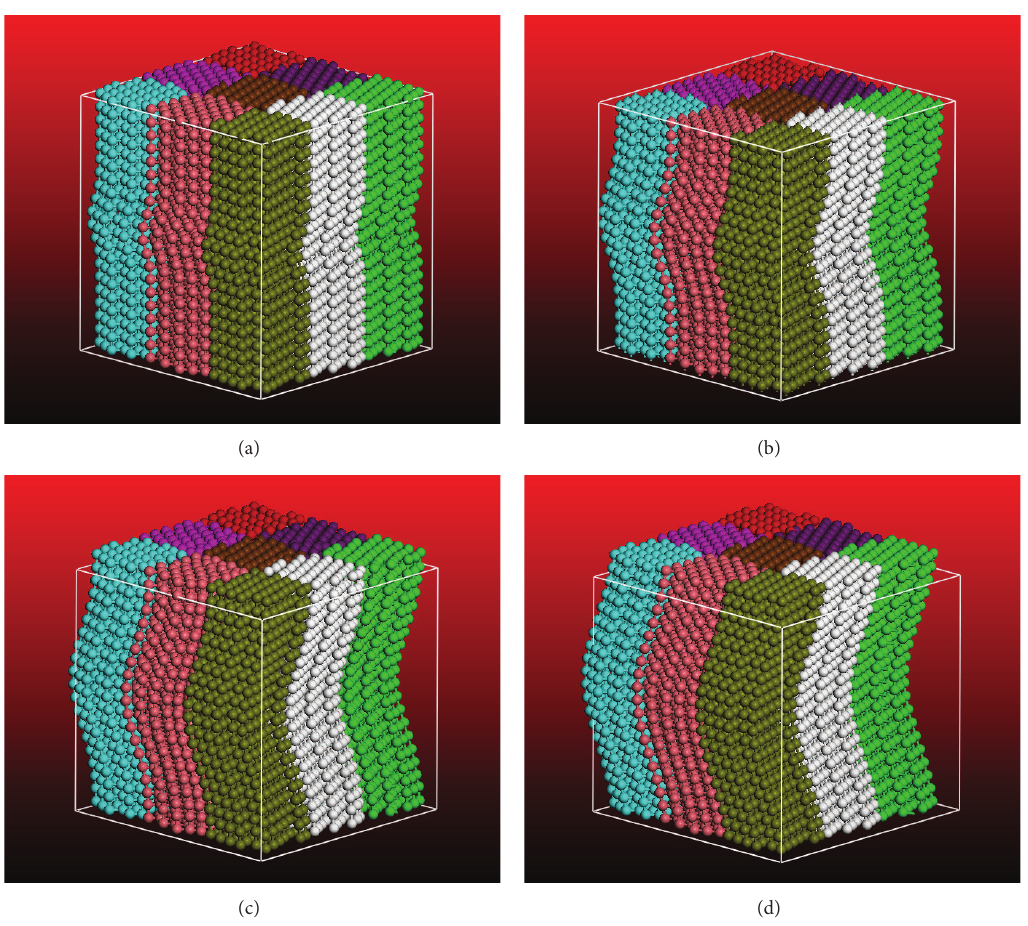
Figure 9: Coarse-grained microstructure, during axial compression, within the computational cell containing (initially) defective virgin PPTA fiber at the longitudinal stretch values of: (a) 0.975; (b) 0.950; (c) 0.925; and (d) 0.900. The fiber within the computational cell contains a cluster of side-group